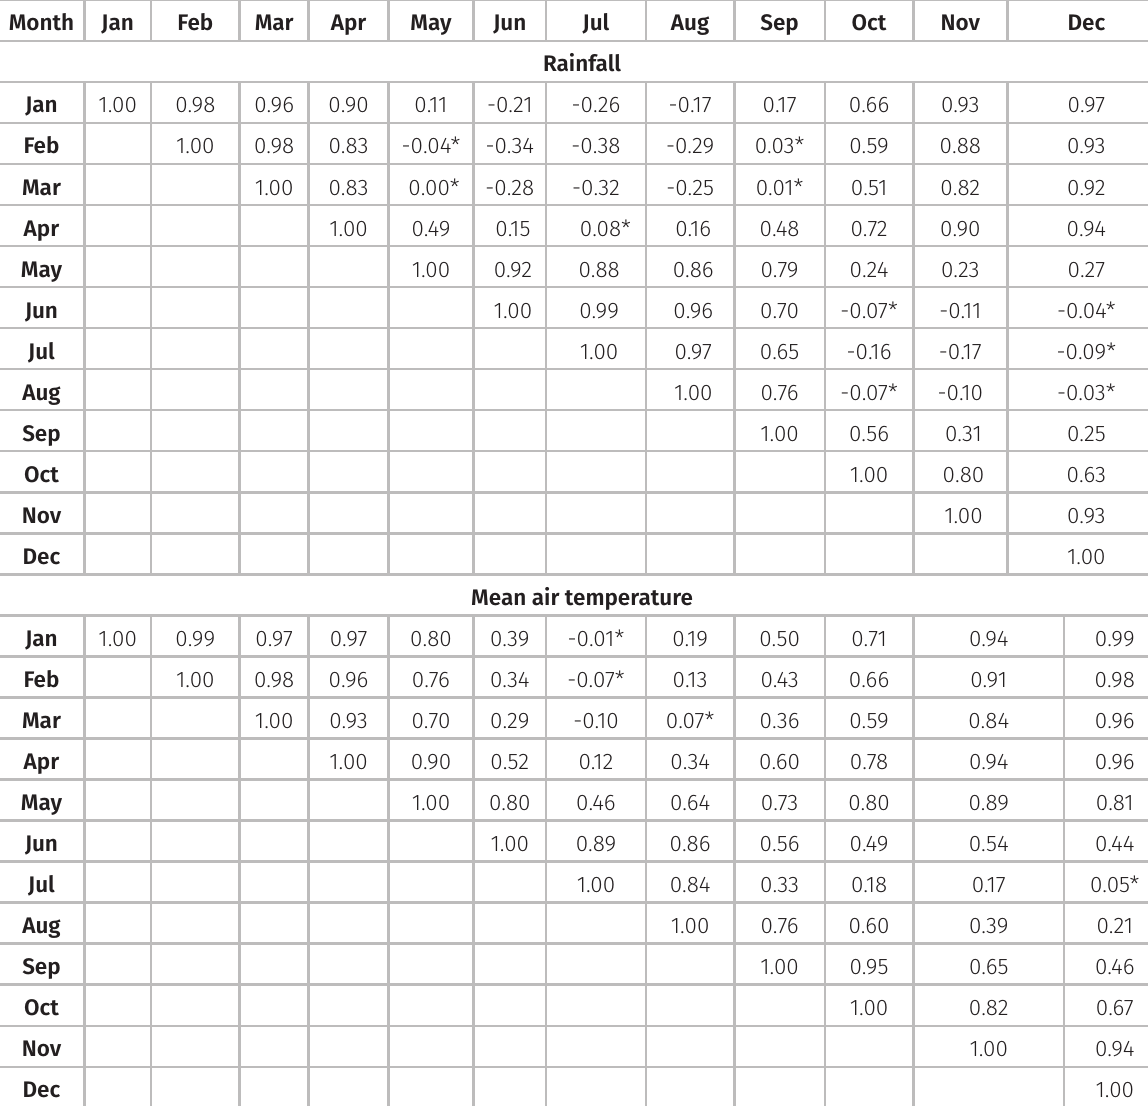
Table II. Pearson linear correlation of the mean monthly rainfall and mean air temperature in the state of Bahia.